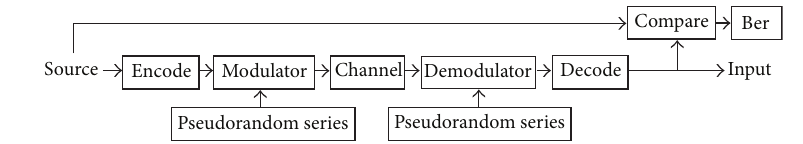
Figure 4: Diagram of intersatellite direct sequence spread spectrum communication